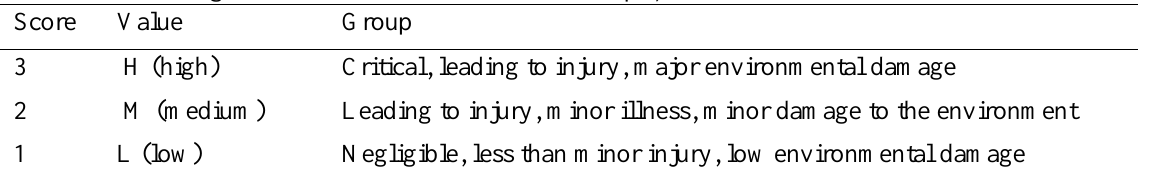
Table 5. Valuating the risk outcomes (Matalucci Rudolph, 2002)